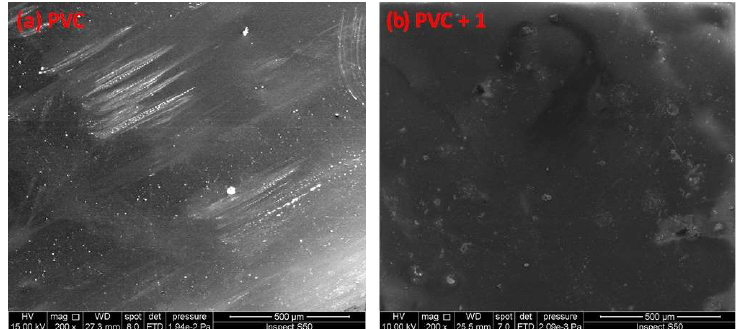
Figure 11. SEM images of the ( a ) blank PVC film and ( b ) PVC + compound 1 film before irradiation. Molecules 2019 , 24 , x FOR PEER REVIEW